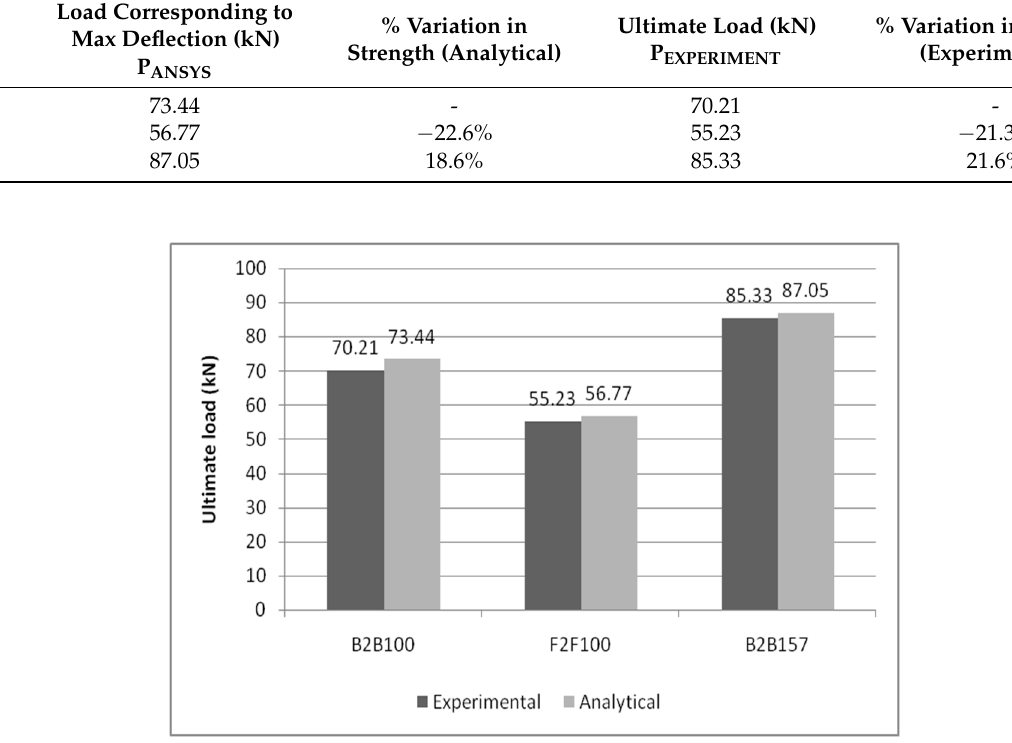
Figure 15. Comparative bar chart of the experimental and analytical results of ultimate load-carrying capacity.